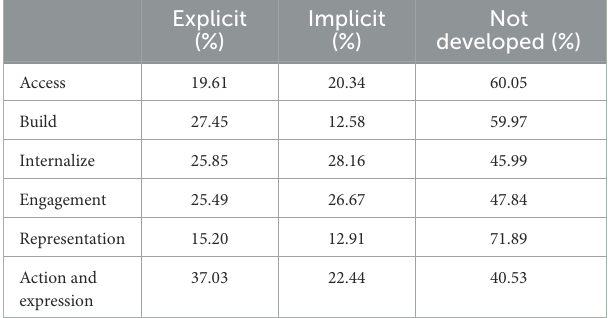
TABLE 5 Percentage of explicit, implicit, and not developed